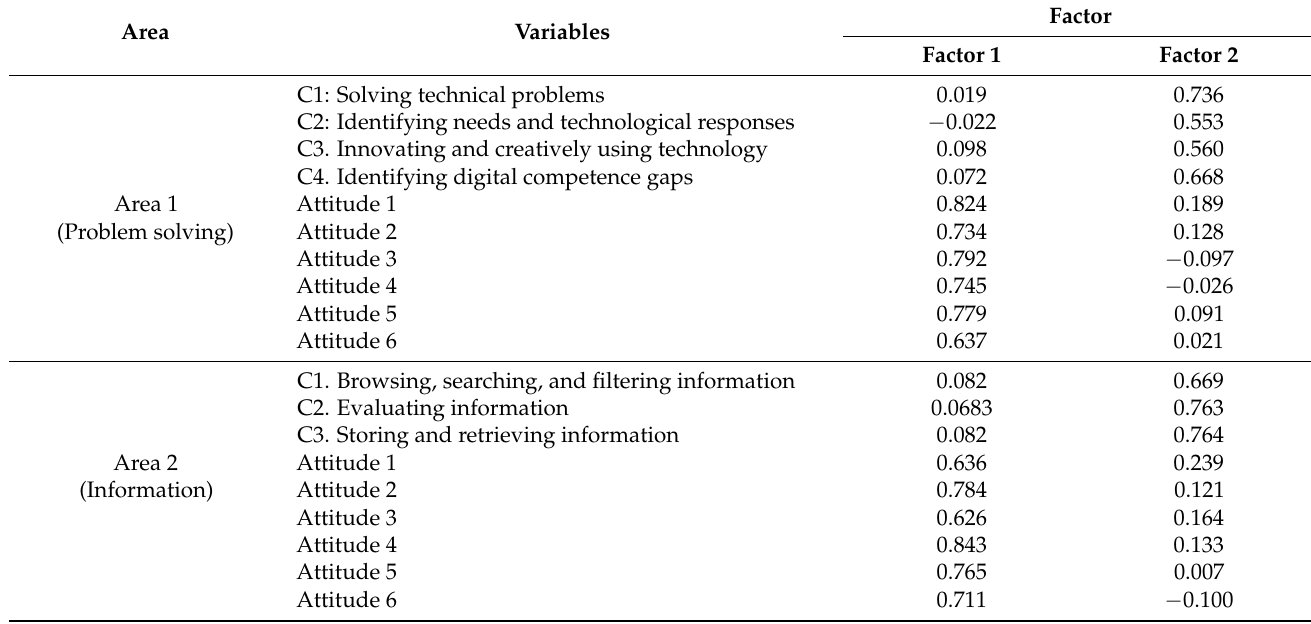
Table 8. Matrix of the principal